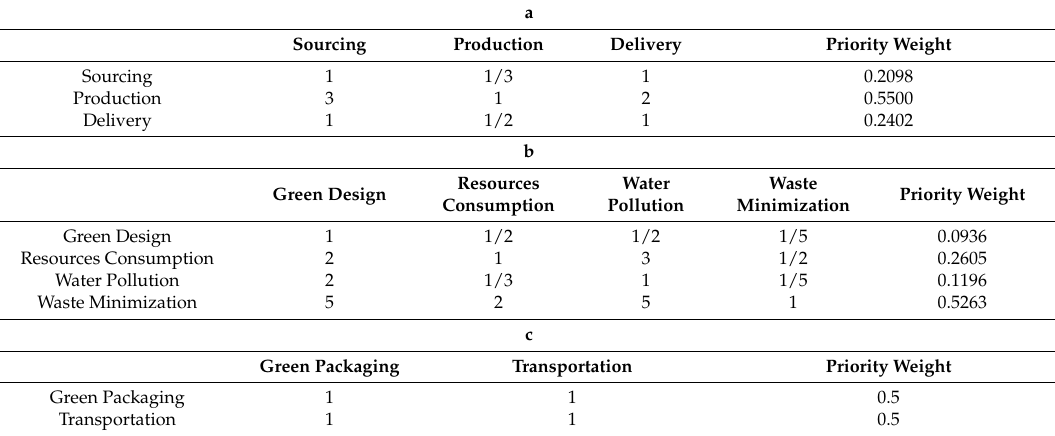
Table 4. Pairwise Comparison of Sub Criteria w.r.t. Environmental Sustainability; Pairwise Comparison of Sub-Sub Criteria w.r.t. sub-criteria Production; Pairwise Comparison of Sub-Sub Criteria w.r.t. sub-criteria Delivery.